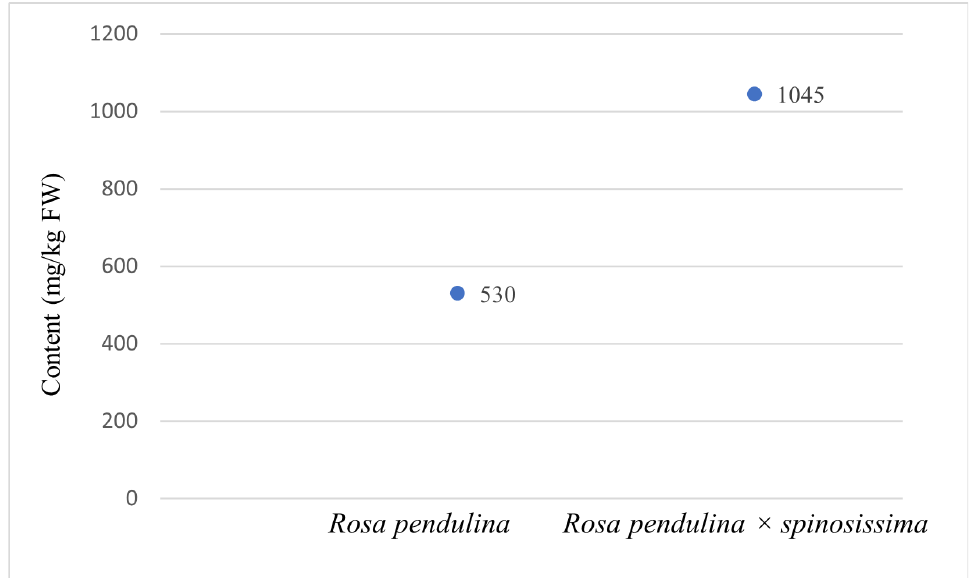
Figure 1. Comparison of the average contents (mg/100 g FW) of ascorbic acid in hips of R. pendulina and the hybrid genotype R. pendulina × spinosissima in the region of Western Slovenia in 2020. Mean values with corresponding standard deviations are presented. Different letters attribute a statistical difference between the average values of ascorbic acid contents in the hips of R. pendulina and R. pendulina × spinosissima . Table 1. The average contents ± standard deviations (mg/kg FW) of organic acids in hips of R. pendulina and the hybrid genotype R. pendulina × spinosissima in the region of Western Slovenia in 2020. Different letters signify a statistical difference between the average values of organic acid contents in the hips of R. pendulina and those of R. pendulina × spinosissima